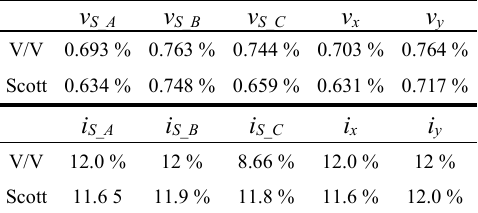
Table 4. THD ratio in the voltages and currents at the three-phase power grid and the railway power system, using V/V or Scott power